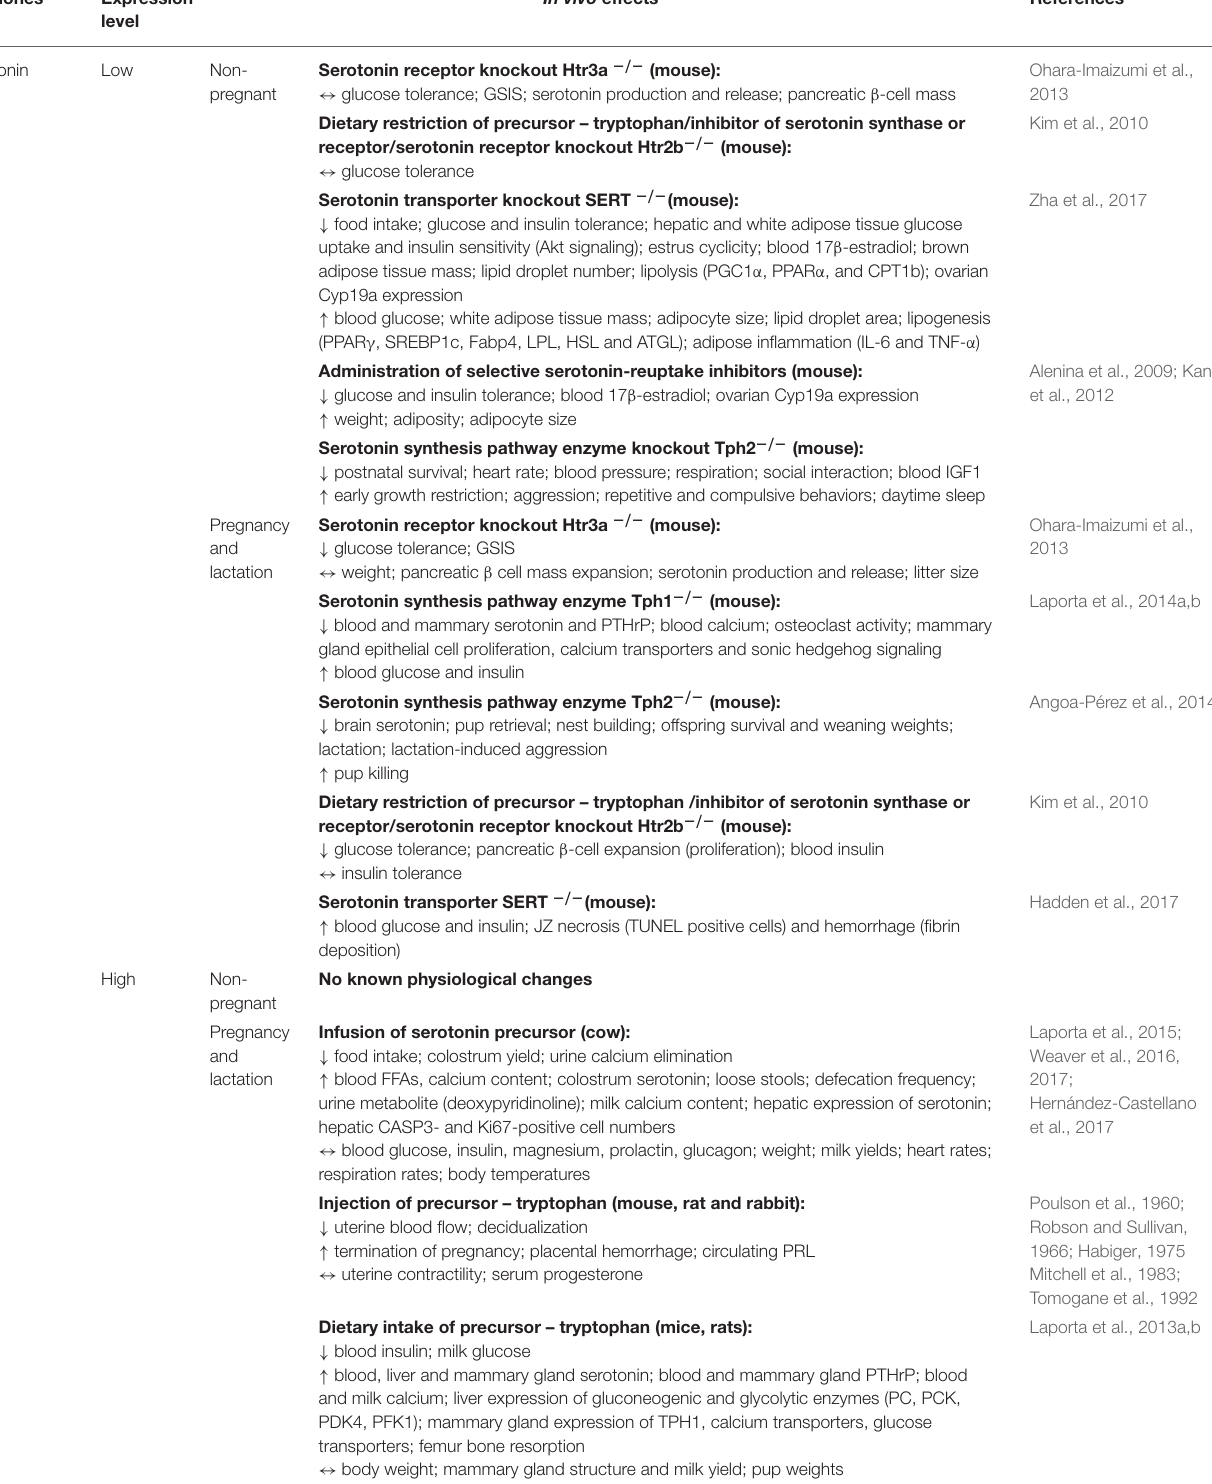
TABLE 5 | Effects of neuropeptides in vivo